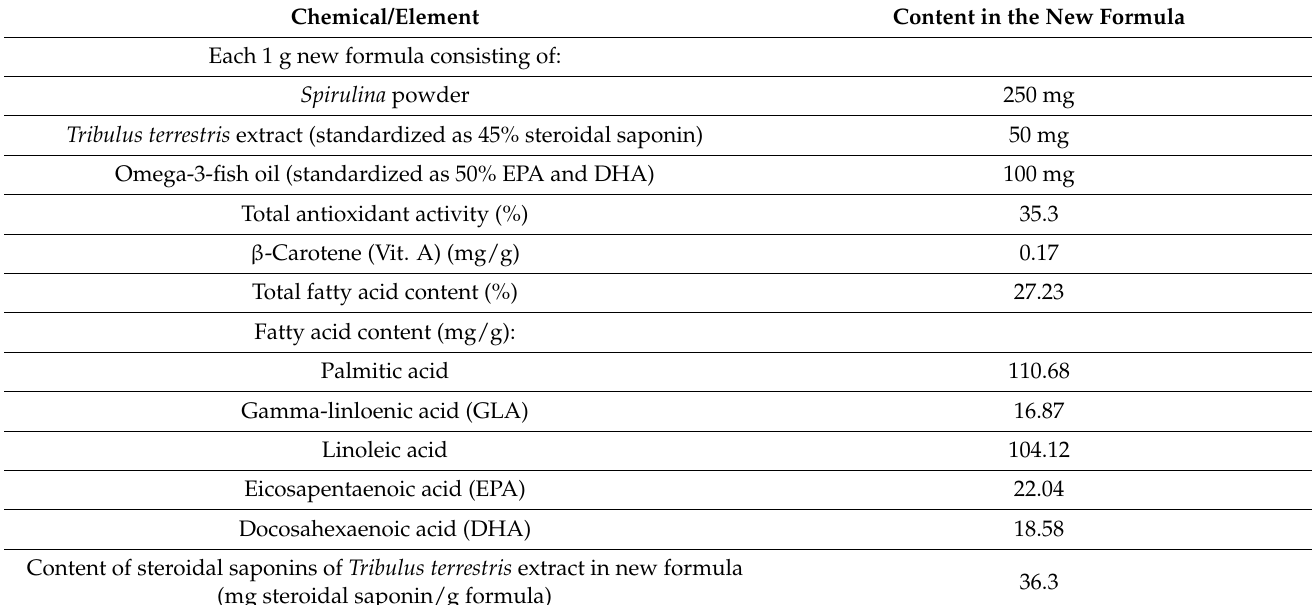
Table 2. The chemical composition and standardization of the